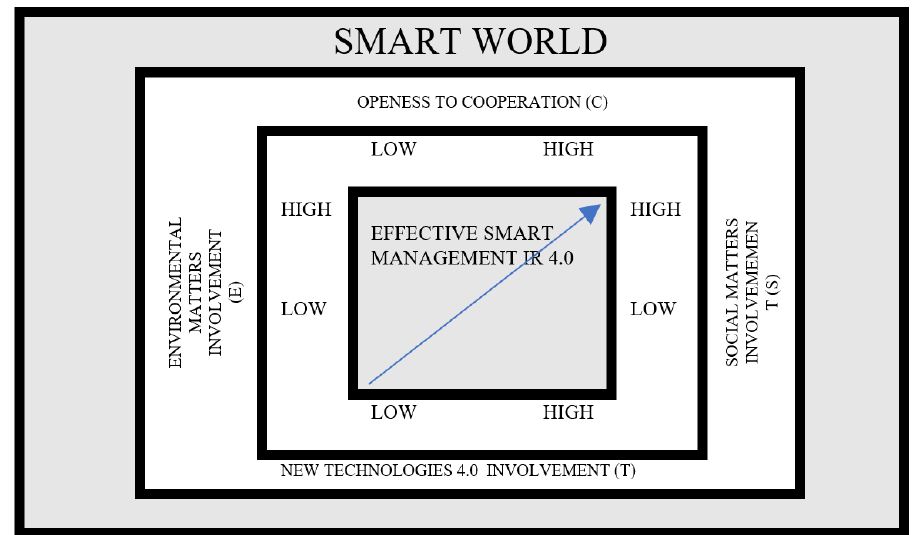
Figure 1. Pillars of Effective Management IR 4.0 era. Source: Own elaboration.